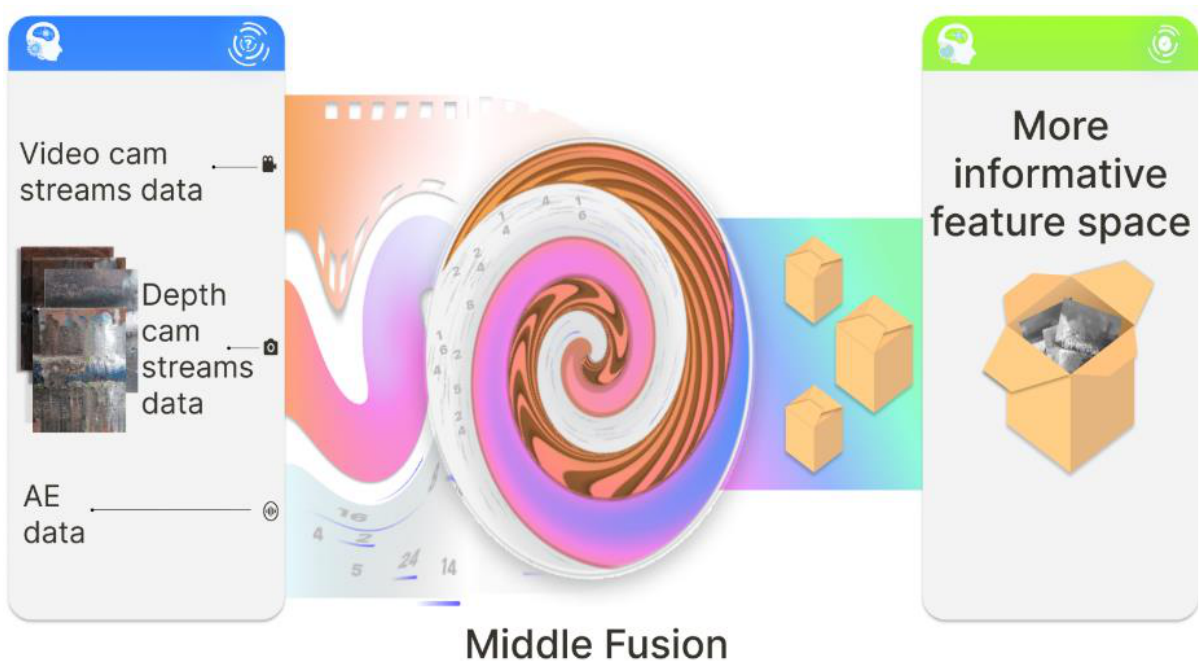
Figure 2. The used raw data streams and the principles of their fusion.